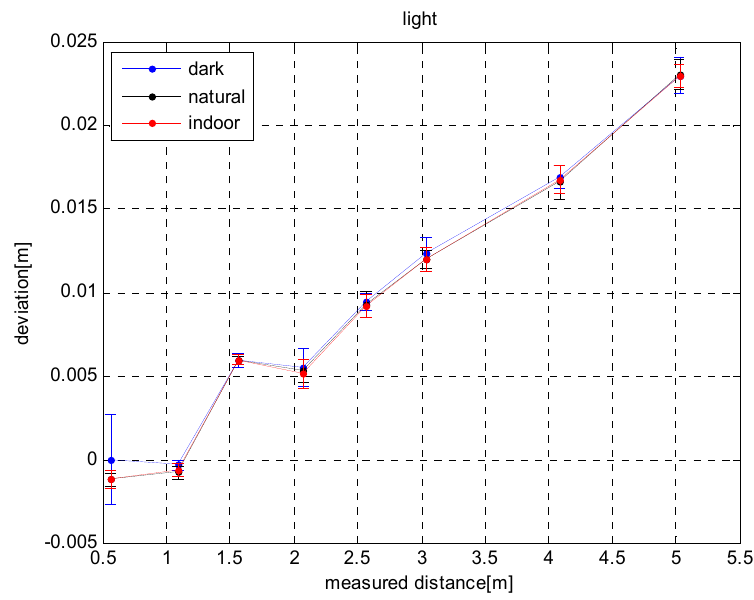
Figure 4. Influence of lighting on depth errors.